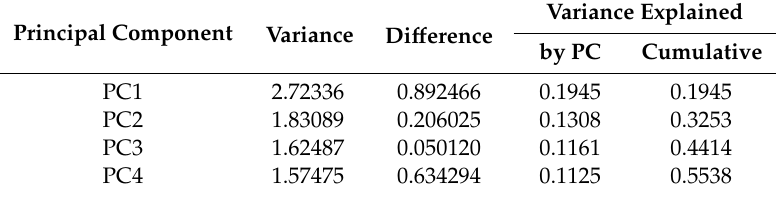
Table 8. Eigen analysis of the correlation matrix using the importance of extrinsic and intrinsic attributes in bread selection (orthogonal Varimax rotation and Kaiser normalisation) ( n =